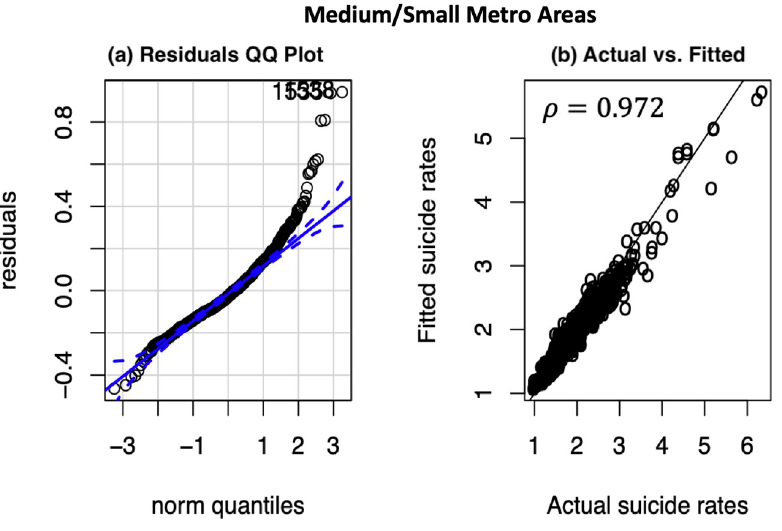
Fig 4. Medium/Small metropolitan counties: Model diagnostics of final random forest model. (A) Residuals QQ plot (the blue dashed lines represent 95% confidence intervals); (B) Predicted versus actual suicide counts, normalized per 100,000 of